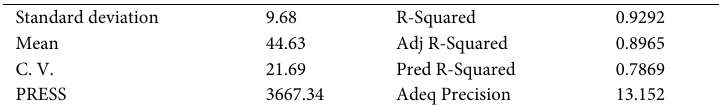
Table 5. Other parameters of statistical value